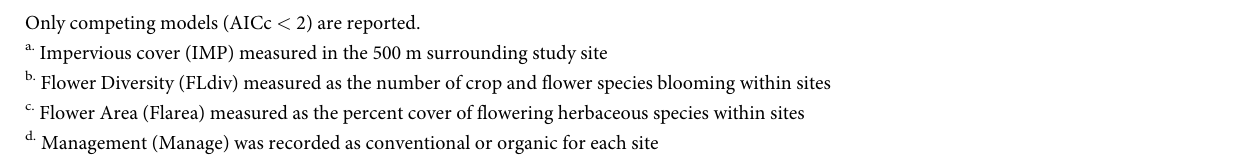
Model results explaining fruit set included only one model, with hardscape as the only explanatory variable. Hardscape accounted for 29% of the model weights and explained 23% of the variation in fruit set (Table 3). Variable weights indicated hardscape was the most influ- ential variable explaining fruit set with a variable weight of 0.66 (Table 4). The remaining vari- ables had similar weights ranging from 0.24 to 0.16 (Table 4). Fruit set was significantly